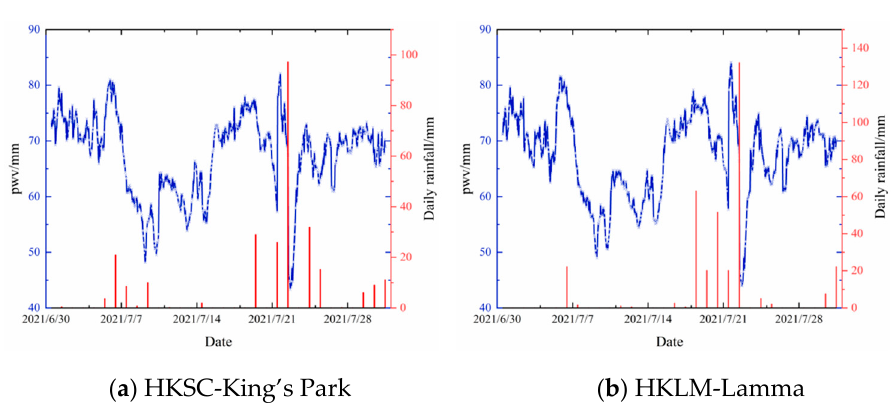
Figure 6. GNSS/PWV versus measured rainfall at ( a ) HKSC-King’s Park Meteorological Station and ( b ) HKLM-Lamma Meteorological Station.